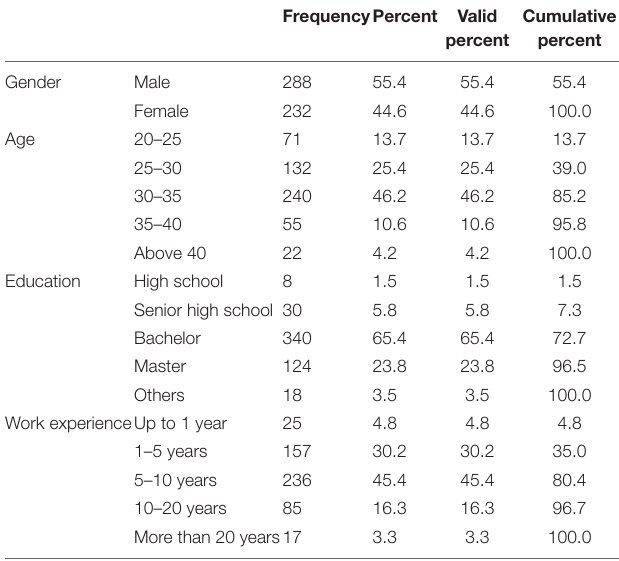
TABLE 1 | Respondent’s demographic